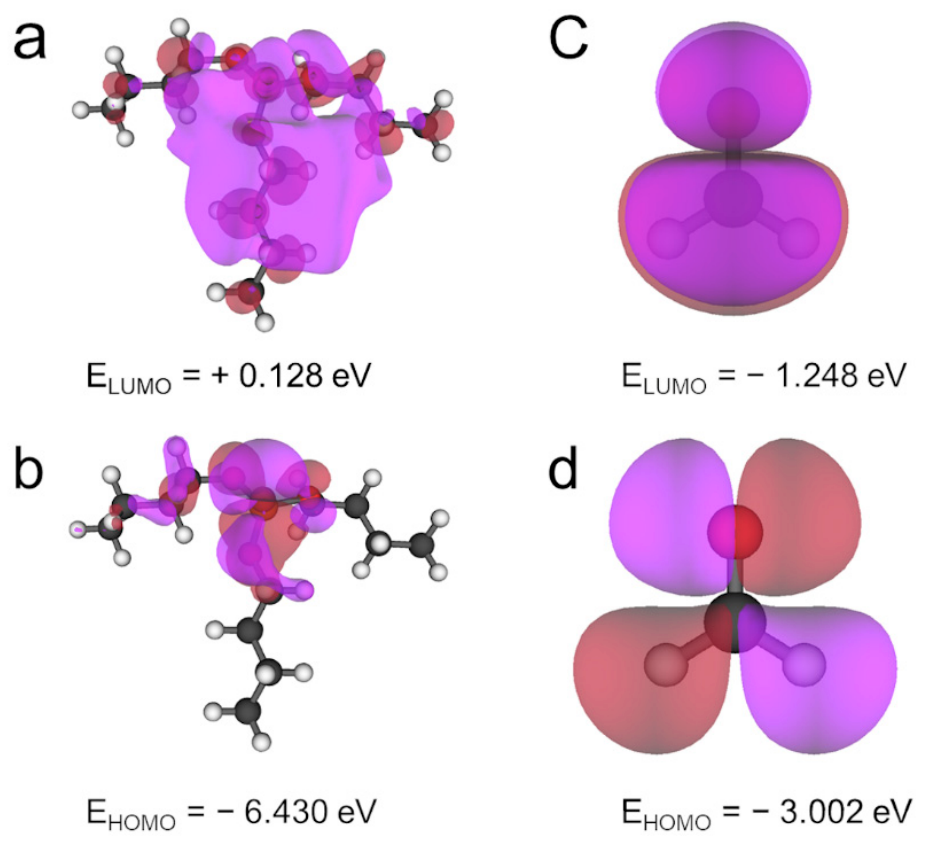
Figure 2. Frontier molecular orbitals for: ( a , b ) TBP molecule and ( c , d ) CH 2 O molecule. Isosurface with isovalue of 0.02 a.u. Table 1. Vertical ionization energy (VIE), vertical electron affinity (VEA) and HOMO–LUMO en- ergy gap for TBP and CH 2 O molecules.